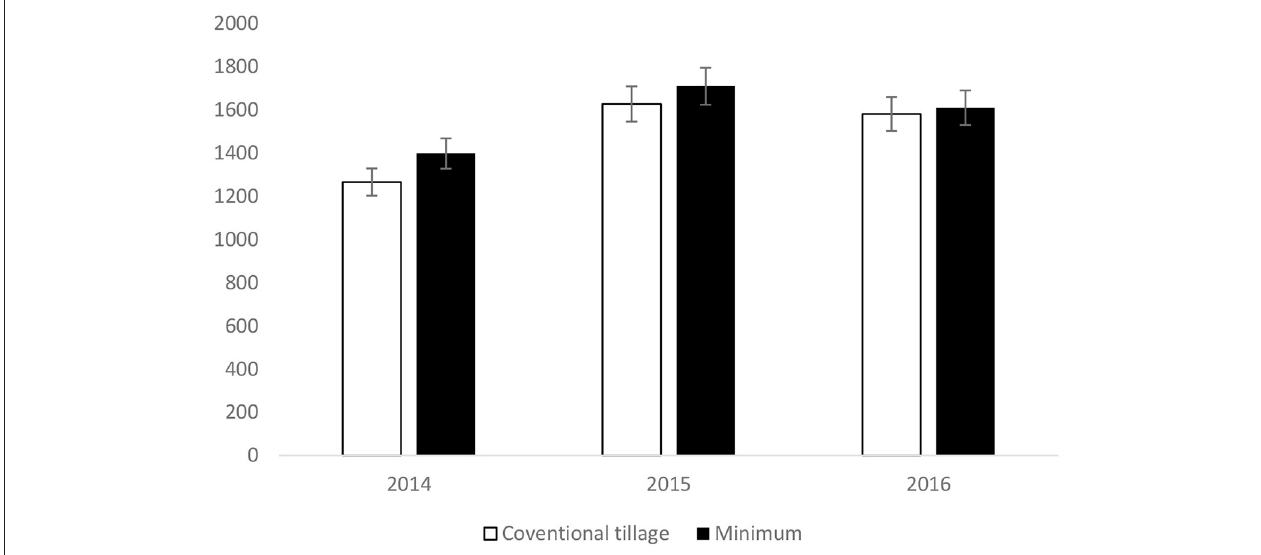
FIGURE 5 | Grain yield in spring wheat as affected by conventional tillage (hollow bars) and minimum tillage (filled bars). Data re-plotted from Yeboah et al.